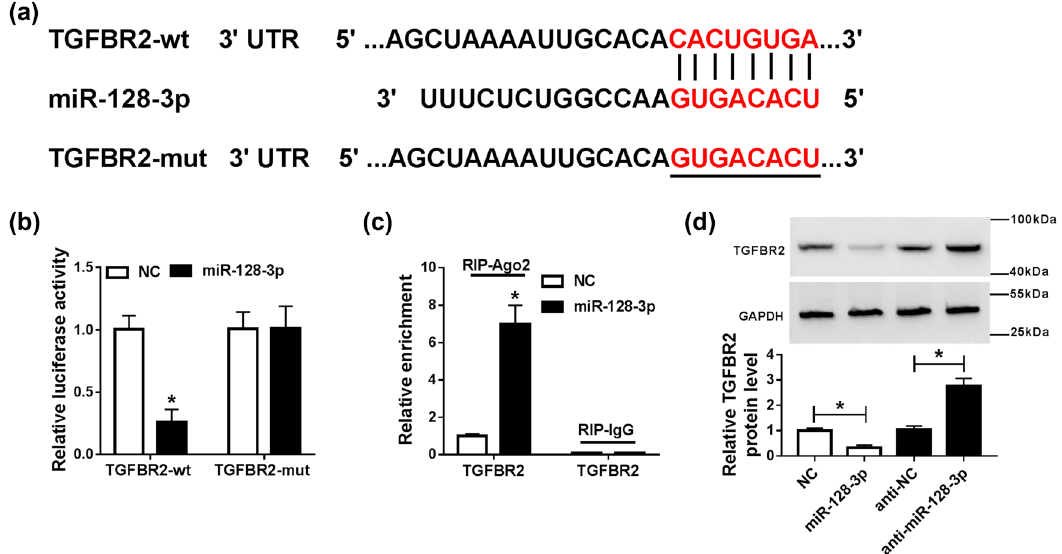
Figure 4: miR - 128 - 3p directly targeted TGFBR2 in HK2 cells. ( a ) The putative binding sites of miR - 128 - 3p and TGFBR2 were provided by TargetScan. ( b ) Luciferase activity was measured in HK2 cells co - transfected with TGFBR2 - wt or TGFBR2 - mut and miR - 128 - 3p or NC by dual - luciferase reporter assay. ( c ) RIP assay was performed to detect TGFBR2 enrichment level in HK2 cells transfected with miR - 128 - 3p or NC. * P < 0.05. ( d ) The protein level of TGFBR2 was measured in HK2 cells transfected with miR - 128 - 3p, NC, anti - miR - 128 - 3p, or anti - NC by western blot analysis. * P <